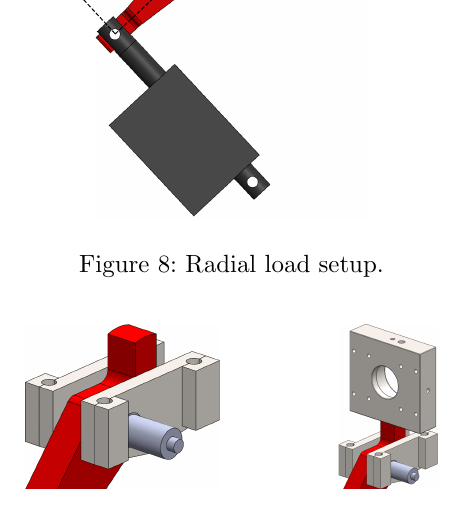
Figure 9: Closeup details of the radial load